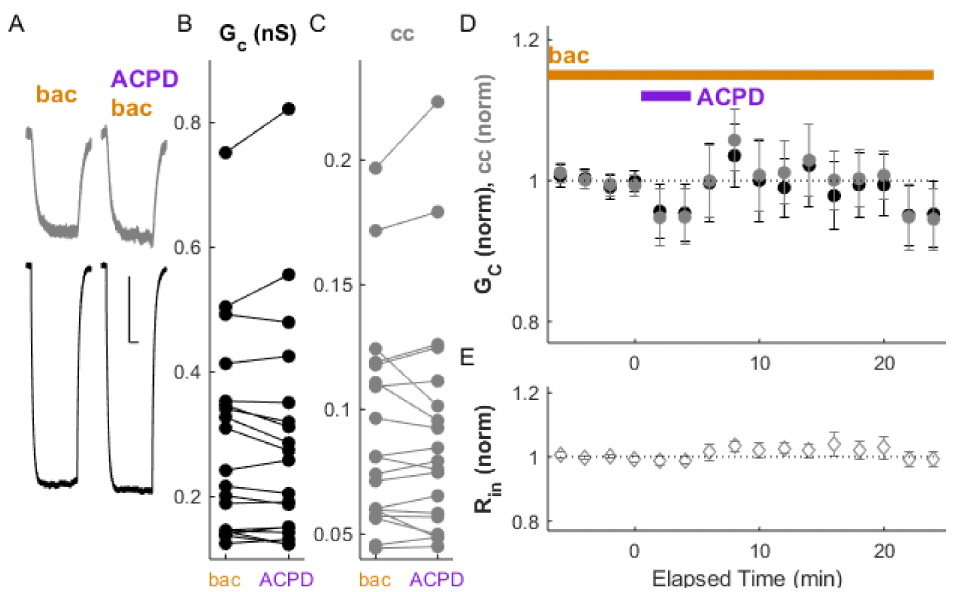
Figure 6. Paired bursting fails to induce LTD in the presence of the GABA B receptor agonist baclofen. ( A ) Example of paired recordings of electrically coupled neurons, in response to a − 100 pA step to one neuron (bottom trace), before and after paired bursting, with baclofen in the bath. Scale bar 100 ms, 5 mV for both responses. ( B ) Conductance G C and ( C ) coupling coefficients cc for the cohort of pairs used in this experiment. ( D ) After paired bursting, ∆ G C (black) was − 0.4 ± 1.8%, p w = 0.4, and ∆ cc (grey) was − 1.2 ± 1.1%, p w = 0.5 from pre-stimulus control ( n = 8 pairs). ( E ) Input resistance for all neurons over the experiment.